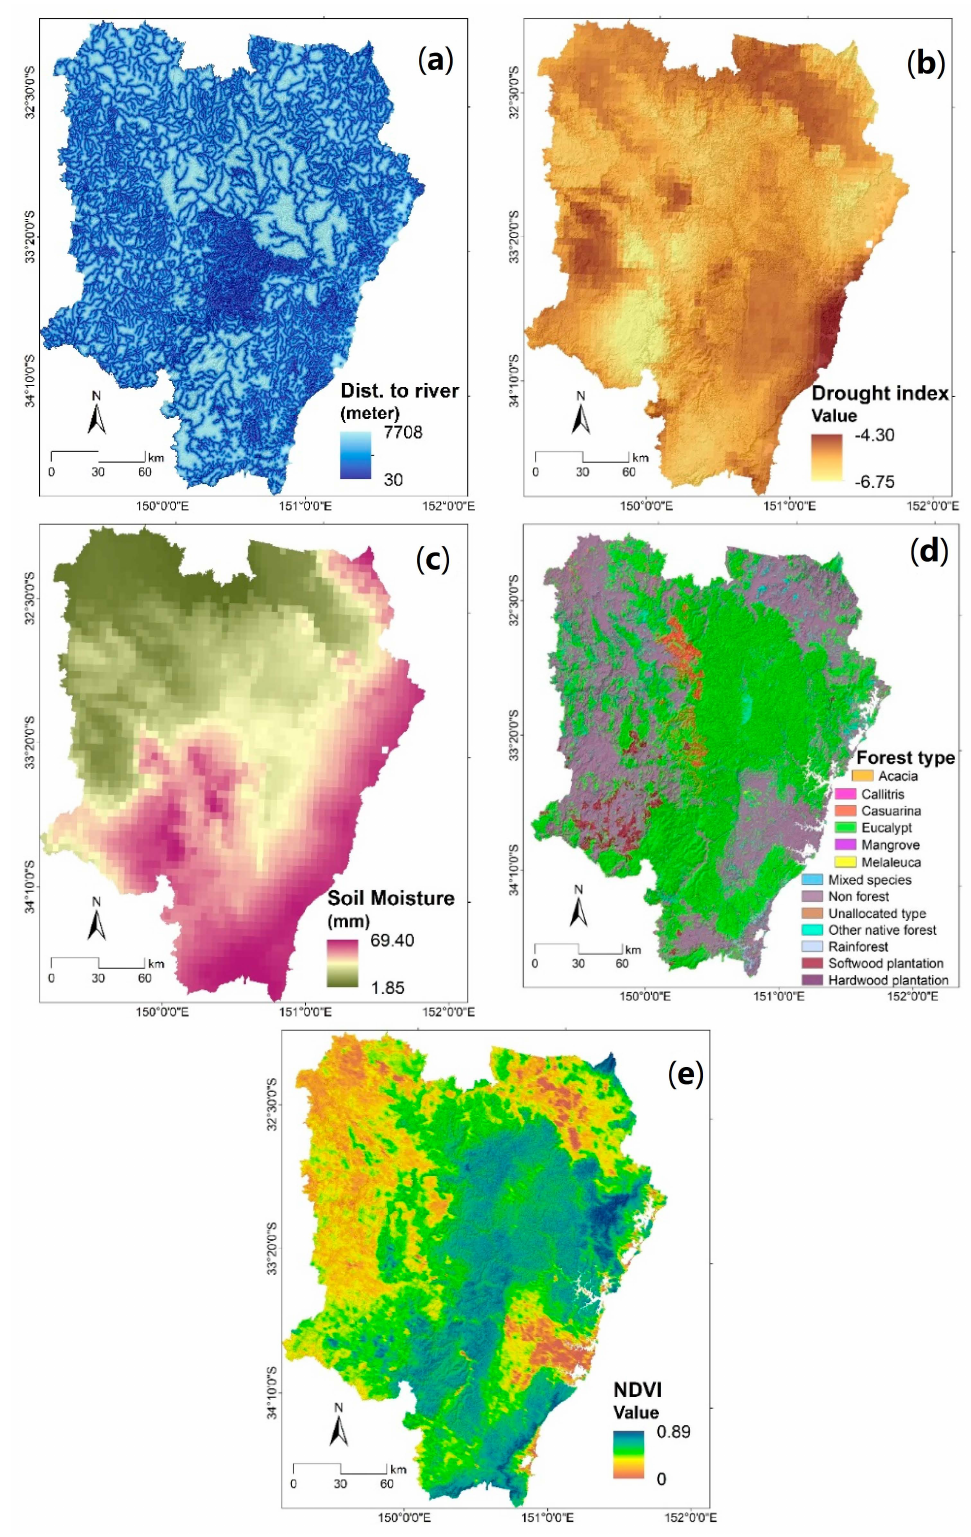
Figure 5. Environmental-related factors: ( a ) distance to rivers, ( b ) drought index, ( c ) soil moisture precipitation, ( d ) forest type, and ( e )